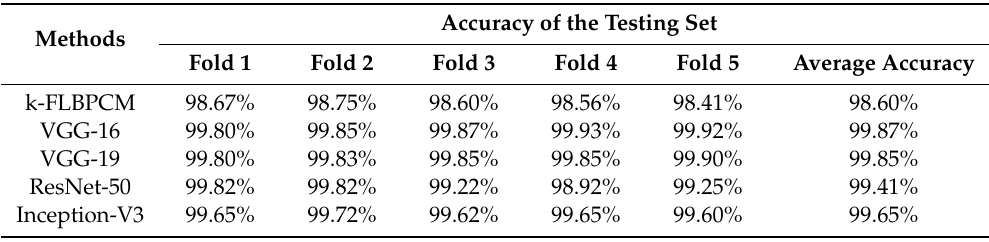
batch size of 32 and dropout 0.2.